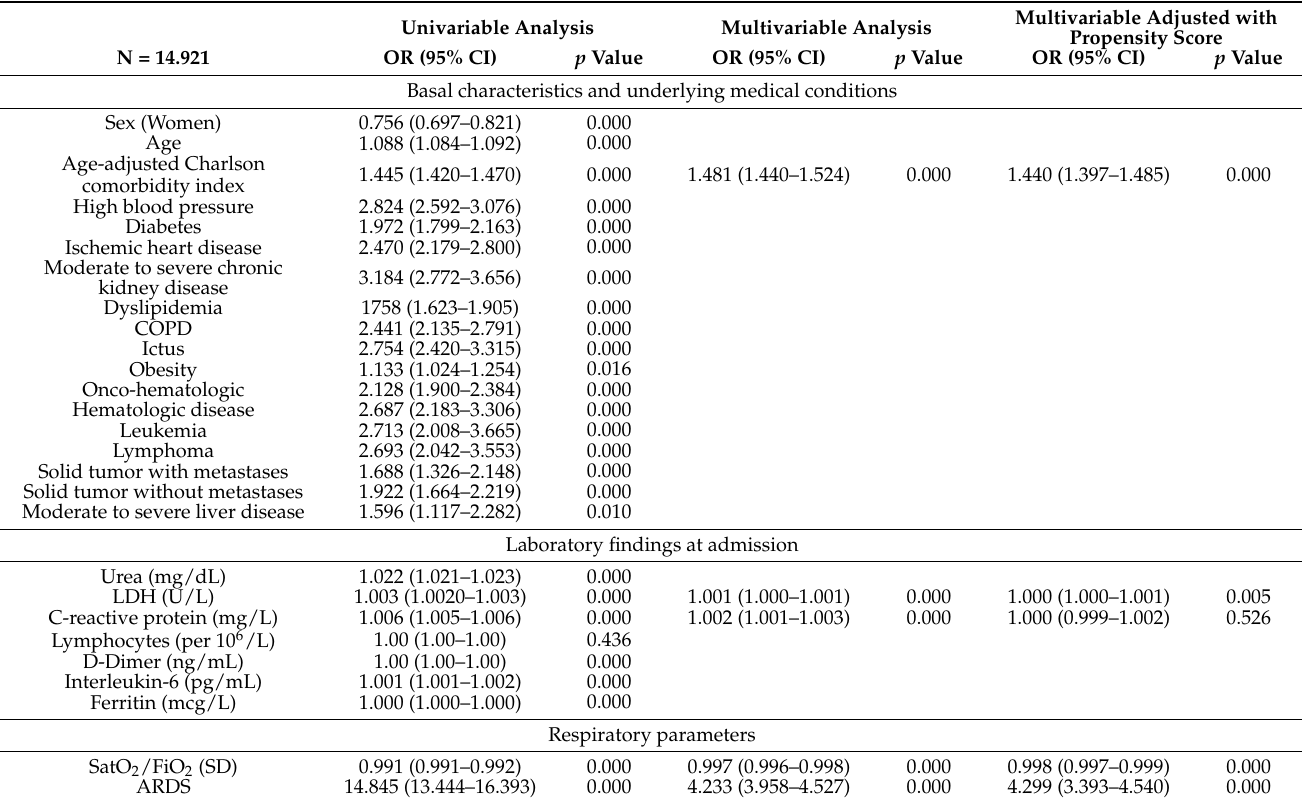
Table 3. Risk factors for mortality in both univariable and multivariable analyses (including a multivariable analysis including the propensity score for steroid treatment as a covariate). Univariable Analysis Multivariable Analysis Multivariable Adjusted with Propensity